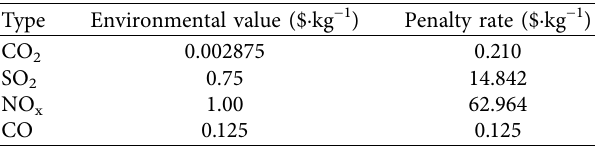
Table 3: Environmental value and penalty rate of different